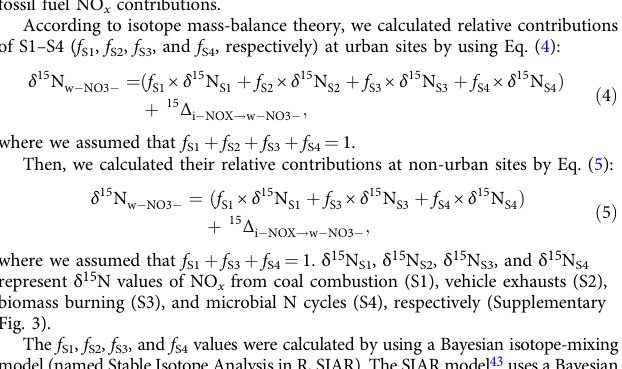
(Fig. 3) were input into the model. In addition, the percentage data of each source ( n = 10,000) output from each run of the SIAR model were used to calculate mean ± SD values of corresponding source contributions (Supplementary Figs. 5 – 8). We calculated the total contribution of each NO x source in each region ( F ; Eq. (6)) by using its annual mean relative contributions at urban and non-urban sites during 2000 – 2017 ( n = 28, 9, 13 for urban sites and n = 47, 21, 88 for non-urban sites in East Asia, Europe, and North America, respectively) ( f urban and f non-urban , respectively; Supplementary Fig. 9) and annual mean proportions of urban and non-urban populations in the total population of each region during 2000 – 2017 ( P urban and P non- urban , respectively; Supplementary Fig.